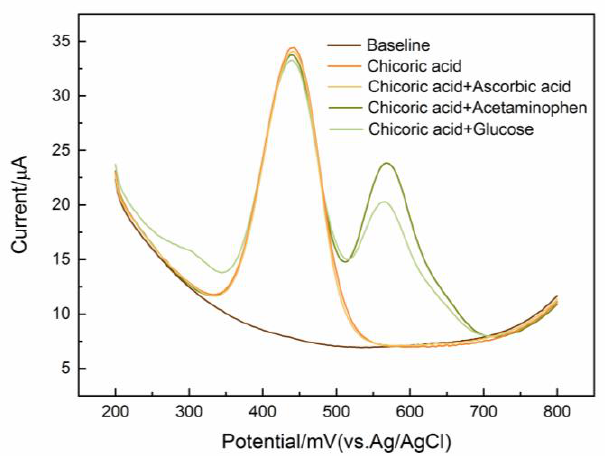
Figure 6. DPV responses of Au@Pt-PEI-RGO / GCE for 0.01 mM chicoric acid in the presence of an excess concentration of interfering substances.